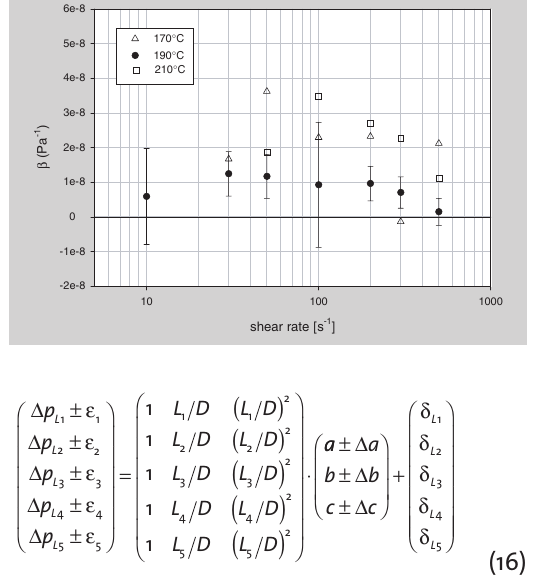
Figure 3 (left): Bagley plots for the LLDPE sample at 190 0 C using dies with D = 1 mm and varying L. Figure 4 (right): Values of the pressure dependency coefficient of the viscosity as calculated from the Bagley plots for LLDPE at 170, 190 and 210 0